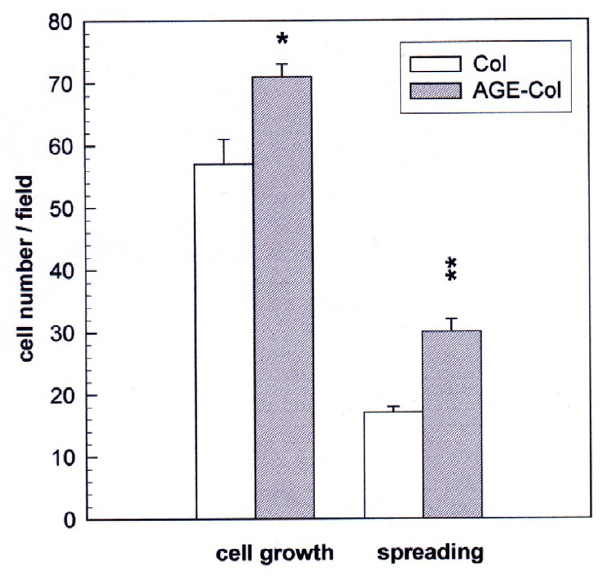
Figure 4 Effect of an AGE-modified type I collagen matrix on MC3T3E1 cell growth. MC3T3E1 calvaria-derived osteoblas- tic cells were cultured on control collagen or AGE-modified collagen at 37 ° C for one week (differentiated osteoblasts) or three weeks (mineralizing cultures). The quantity of cells growing on the corresponding collagenous matrices at each timepoint, was evaluated by trypsinization and cell counting with a haemocytometer. Results are given as the number of cells counted in each case, and are expressed as the mean ± SEM. Differences between collagen vs. AGE-collagen are as follows: **